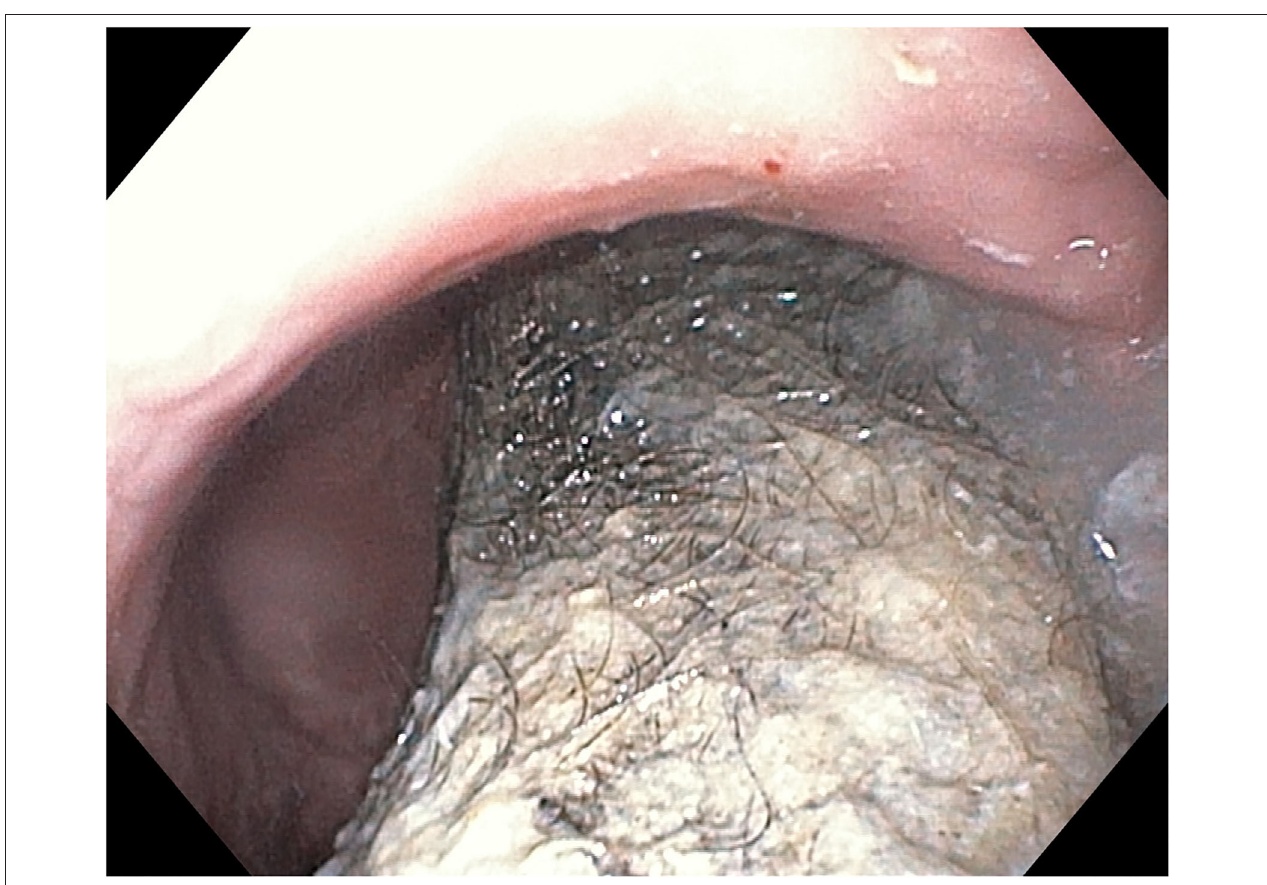
FIGURE 2 | Endoscopic aspect of trichobezoar—at the level of gastric corpus and